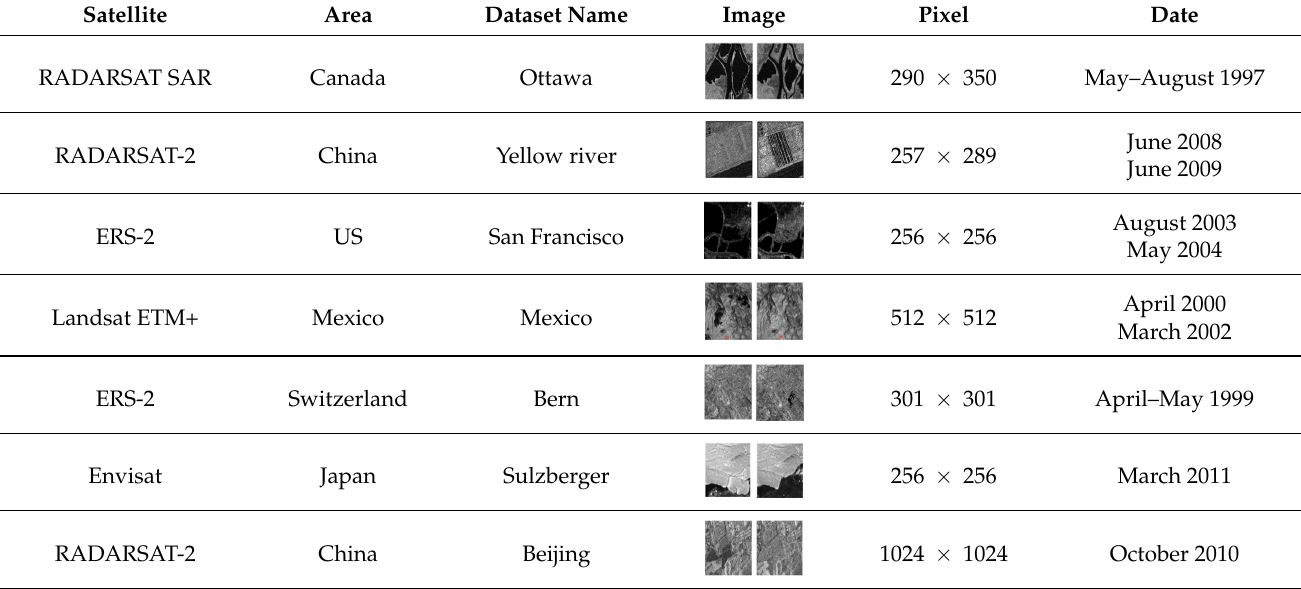
Table 3. Illustration of SAR